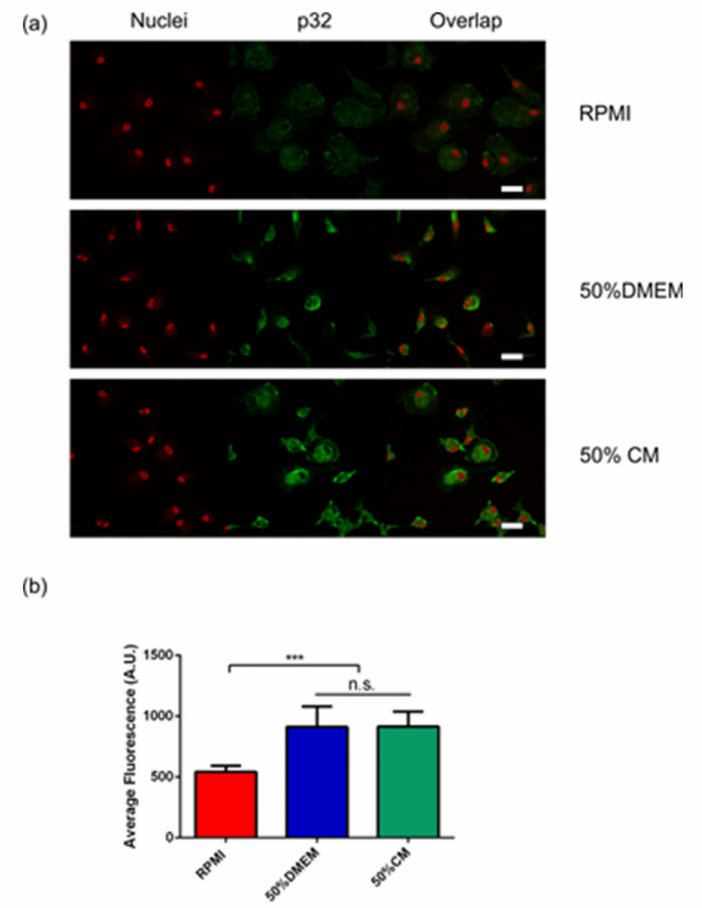
Figure 2. Primary human monocytes express p32/gC1qR when M2 markers increase. ( a ) Primary human monocytes were incubated with complete RPMI (RPMI), RPMI + 50% complete DMEM low glucose (50%DMEM) and RPMI + 50% U87MG conditioned media (50% CM) for 5 days and were subsequently fixed and stained for p32/gC1qR as explained in materials and methods. ( a ) Rep- resentative images of stained cells; nuclei are counterstained in red (red dots) and p32/gC1qR is shown in green (Alexa 488). ( b ) Statistical analysis showing the relative fluorescence in arbitrary units (A.U.) for cells incubated in the conditions explained above. A statistically significant increase in p32/gC1qR staining was detected in cells incubated in 50% DMEM and in 50% CM, n = 3. A One-way Anova was performed ***: p ≤ 0.001. Scale bar: 20 µ